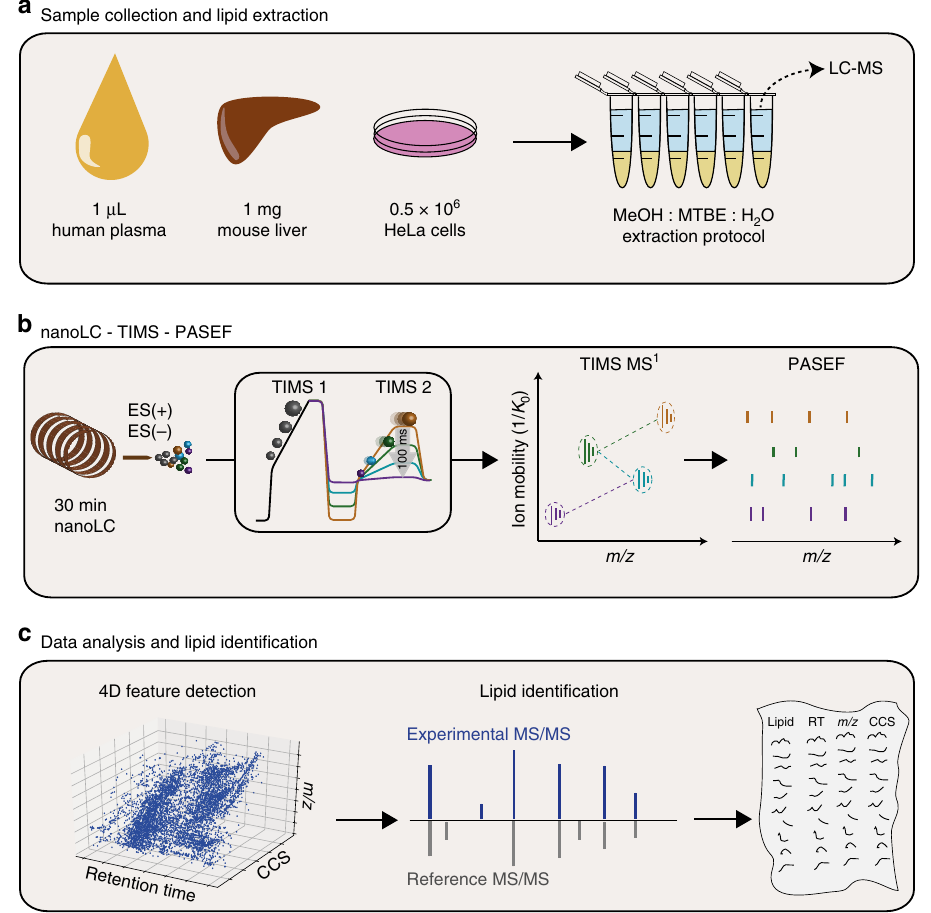
Fig. 1 Nano fl ow lipidomics with trapped ion mobility spectrometry. a Lipids from various biological sources, such as body fl uids, tissues and cells, are analyzed using a single MeOH:MTBE extraction. b The crude extract is injected into a nano fl ow liquid chromatography (LC) system coupled online to a high-resolution TIMS quadrupole time-of- fl ight mass spectrometer (timsTOF Pro). In the dual TIMS analyzer, ions are accumulated in the front part (TIMS 1), while another batch is released as a function of ion mobility from the TIMS 2 analyzer. PASEF synchronizes precursor selection and ion mobility separation, which allows fragmenting multiple precursors in a single TIMS scan at full sensitivity. c Features are extracted from the four-dimensional (retention time, m/z , ion mobility, intensity) data space and assigned to PASEF MS/MS spectra for automated lipid identi fi cation and compilation of comprehensive lipid CCS libraries. MeOH = methanol, MTBE = methyl-tert-butyl ether, CCS = collisional cross